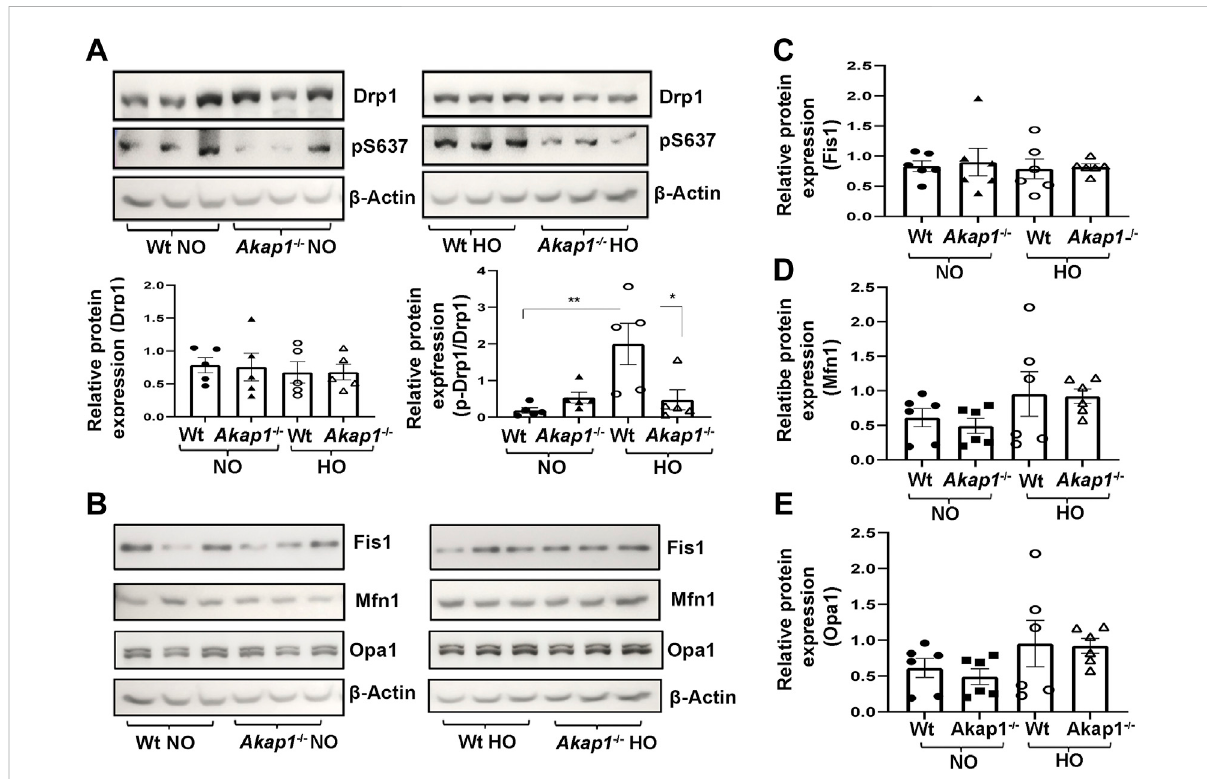
FIGURE 5 Akap1 deletion decreases the phosphorylation of Drp1 at Ser637 under oxidative stress without affecting other fi ssion or fusion protein expression. (A) Representative Western blot of total Drp1 and phosphorylated Drp1 (pS637) expression in the lung lysates derived from Wt and Akap1 − / − mice exposed to normoxia or hyperoxia. Total Drp1 and pDrp1/Total Drp1 expression were quantitated after normalization with β -Actin control. Data represented as mean ± SEM. n = 5 mice per group. One-way ANOVA and post-hoc Tukey test. * p < 0.05 Wt hyperoxia versus Wt normoxia. ** p < 0.01 Akap1 − / − hyperoxia versus Wt hyperoxia control. (B) Representative Western blots of Fis1, Mfn1 and Opa1 expression in the lung lysates derived from Wt and Akap1 − / − mice exposed to normoxia or hyperoxia. (C – E) Quantitative expression of Fis1, Mfn1 and Opa1 after normalization with β -Actin control. Data represented as mean ± S.E.M. n = 6 mice per group. NO = normoxia. HO =